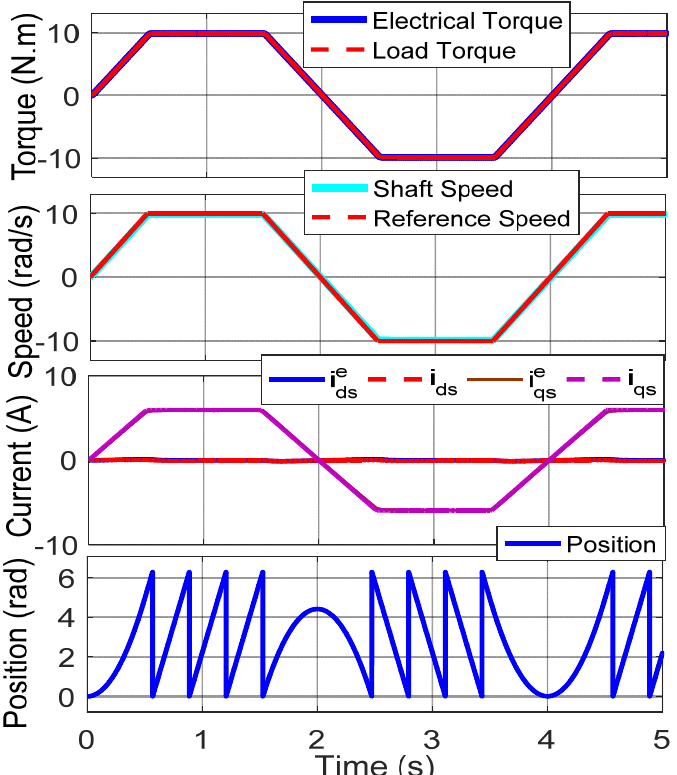
Figure 5 . The drive was tested for the forward and reverse motoring operations for the ramp speed commands.